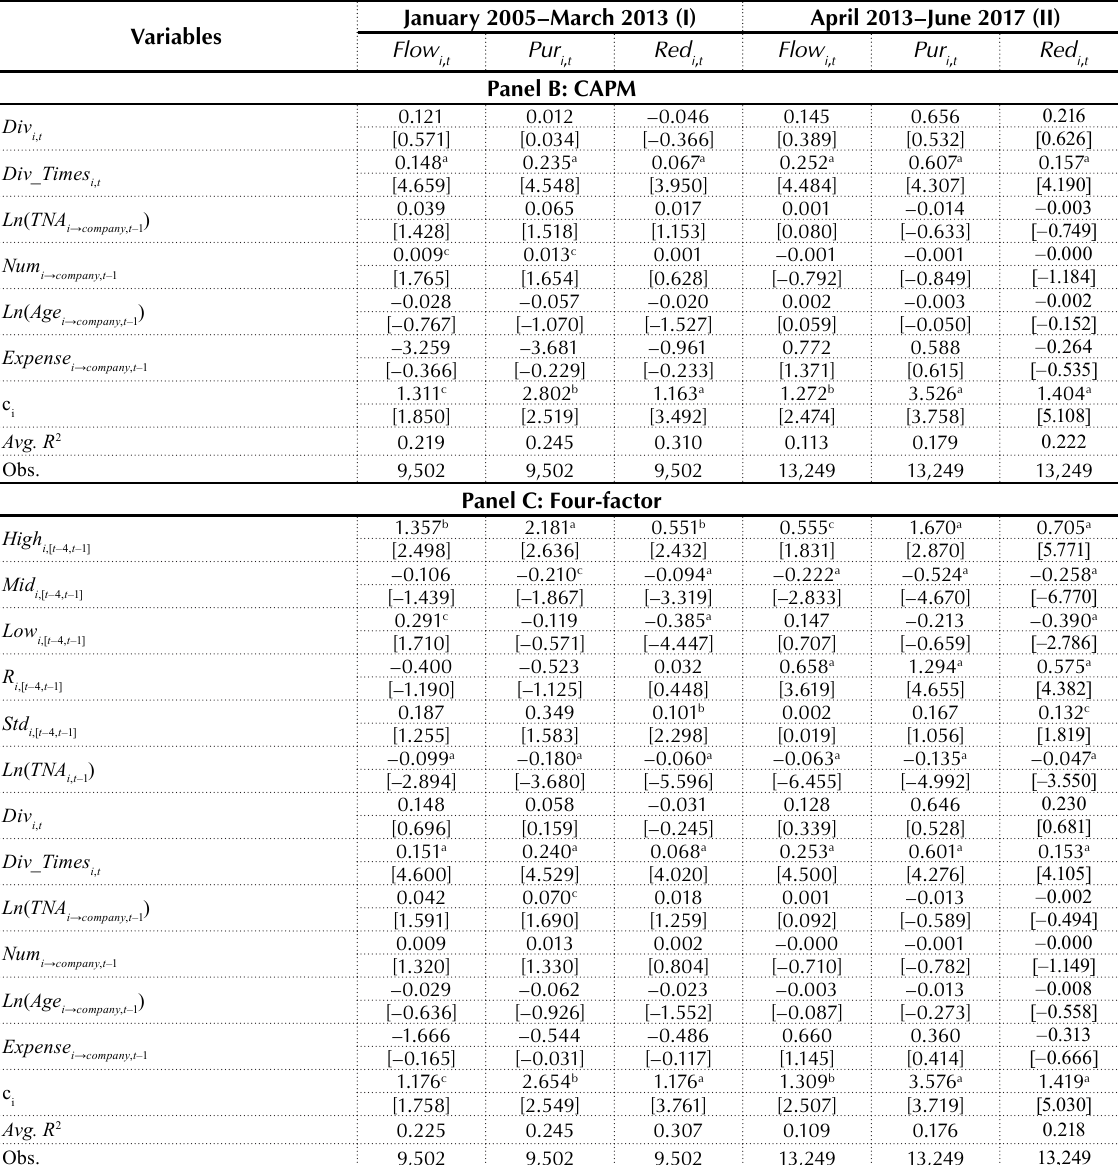
Table 8 (cont.). Robustness test on two subperiods: the adoption of tradable